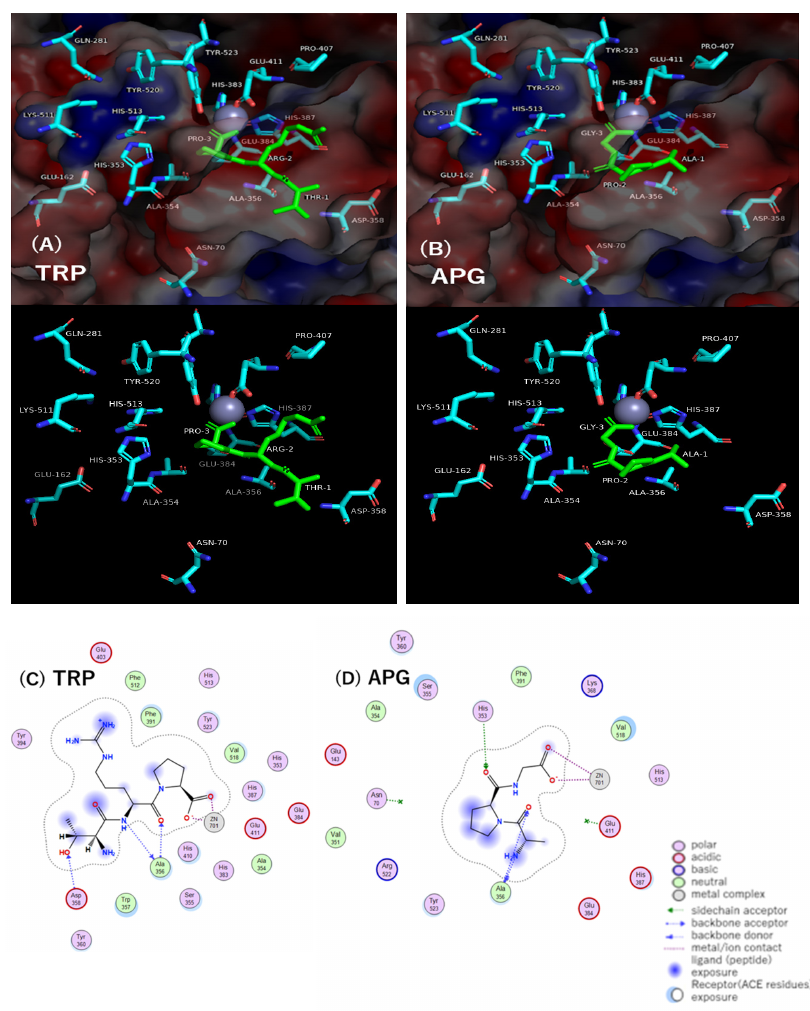
Figure 2. Docking simulation of the interaction between peptides and amino acid residues and Zn(II)701 at active site of ACE (PDB ID code: 1O8A) in the states with the smallest docking score S values of − 11.1199 and − 9.3226 for TRP and APG, respectively. ( A , B ) 3D structure of the complex with peptides and ACE residues. Peptide is shown in green. Red: negative charge of ACE residues, blue: positive charge of ACE residues. The surface charge of ACE is shown in the upper figure and hidden in the lower figure. ( C , D ) 2D diagram of intermolecular interaction between peptides and ACE residues.